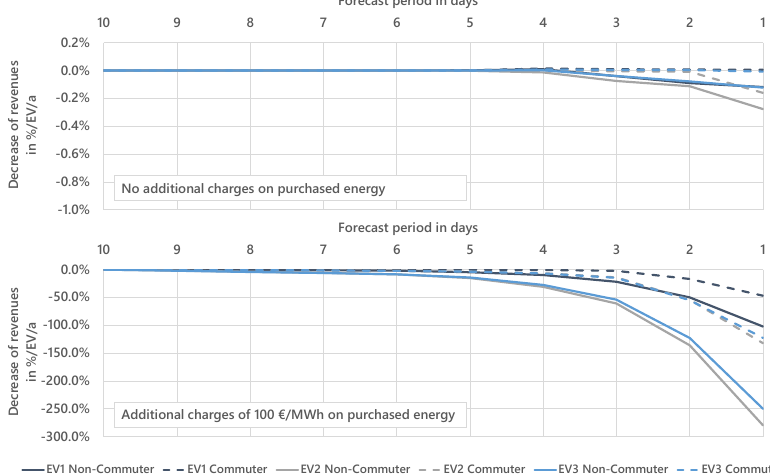
Figure A1. Influence of forecasting horizon on revenue potentials of bidirectionally chargeable EVs for the use cases of arbitrage trading with no additional charges (top) and additional charges of 100 € / MWh (bottom) on purchased